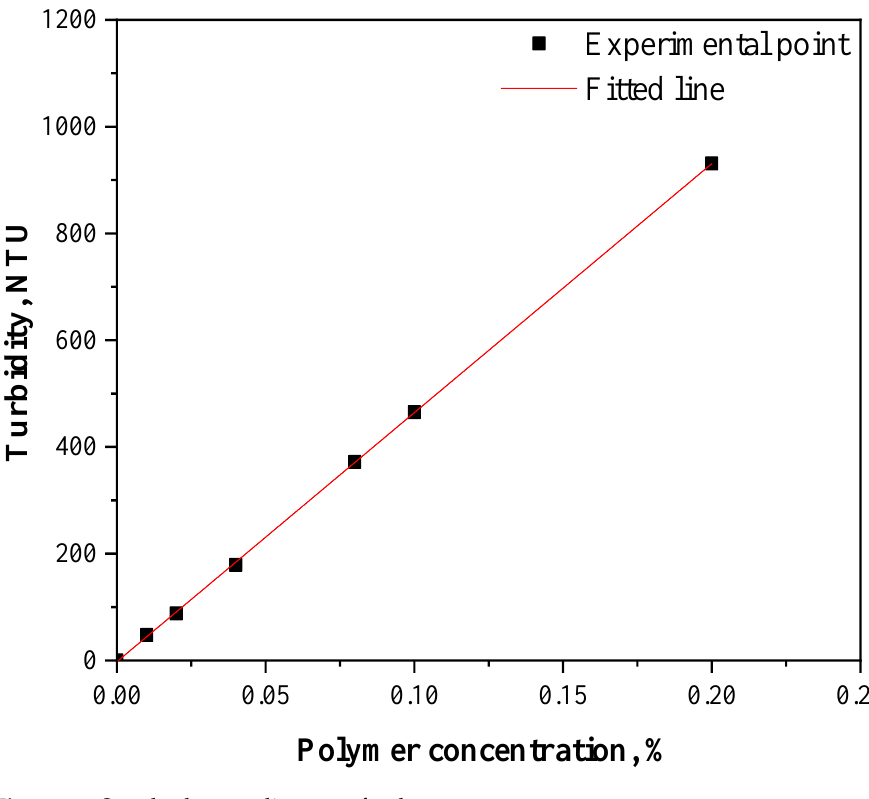
Figure 13. Standard curve diagram of polymer.